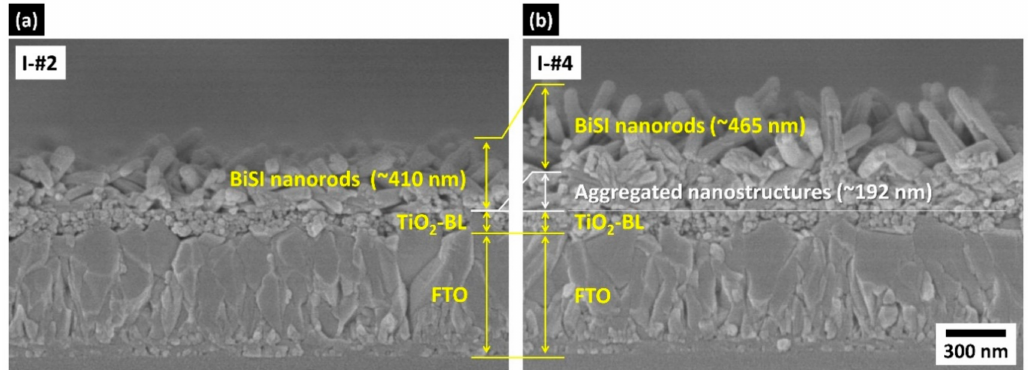
Figure 4. Cross-sectional FESEM images of ( a ) I-#2 and ( b ) I-#4 samples prepared after step II.